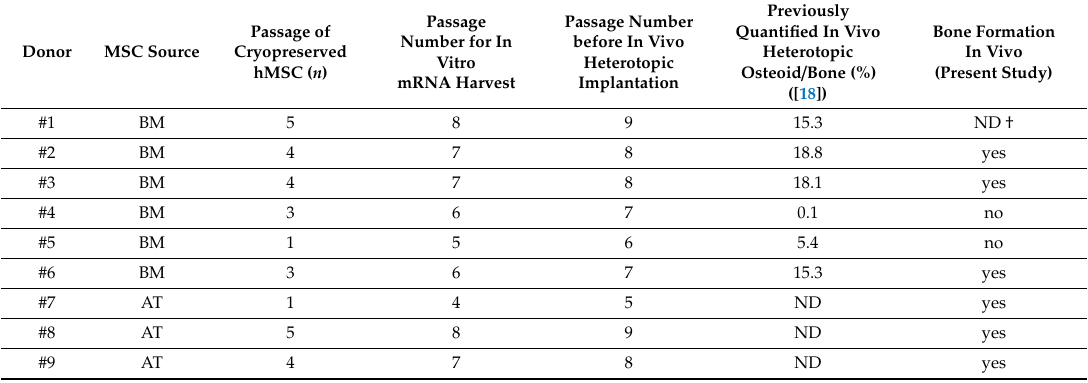
Table 3. Overview of the number of hMSC passages in vitro and osteogenesis in